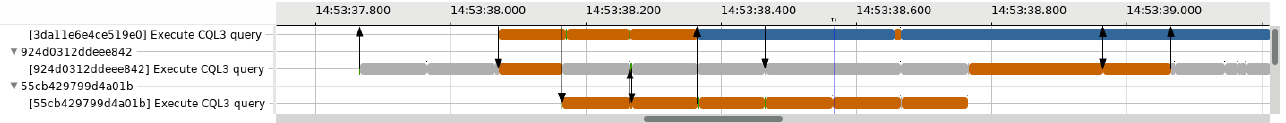
Figure 15. Use case: pattern of preemption. Request 55cb429799d4a01b takes about 600 ms to process but shows a pattern of recurring preemption every 100 ms.